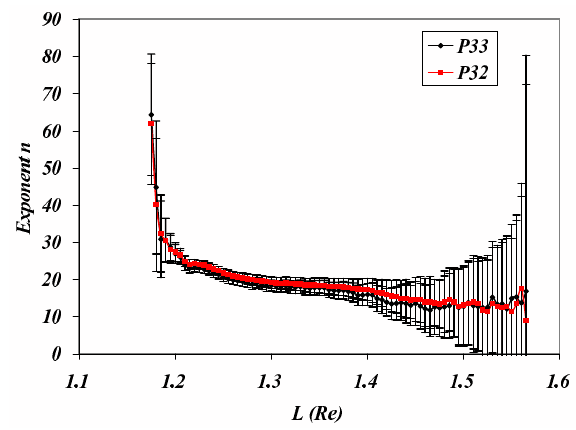
Fig. 6. Pitch angle distribution parameter n as a function of the McIlwain L coordinate for the 20–80MeV (black) and 40–100MeV (red) energy channels. High values of statistical uncertainty at the lower and upper ends of the L range result from poor statistics.